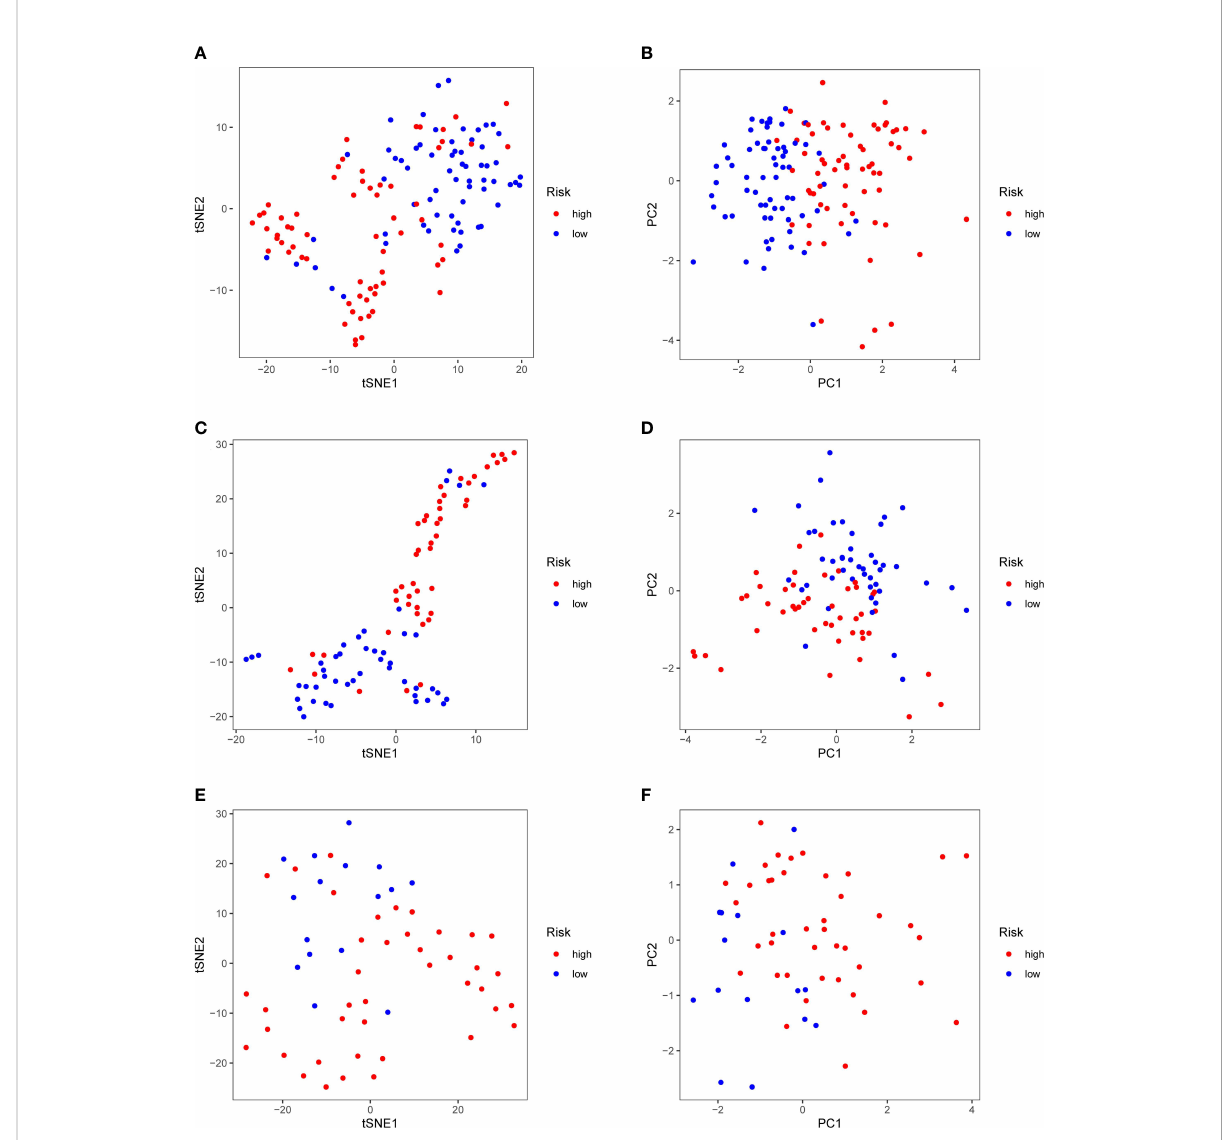
FIGURE 4 PCA and t-SNE analysis. tSNE (A) and PCA (B) dimension reduction analysis of the high- and low-risk groups based on the riskscore in TCGA cohort. tSNE (C) and PCA (D) dimension reduction analysis of the high- and low-risk groups based on the riskscore in ICGA cohort. tSNE (E) and PCA (F) dimension reduction analysis of the high- and low-risk groups based on the riskscore in FAHWMU cohort. (high: high-risk group; low: low-risk